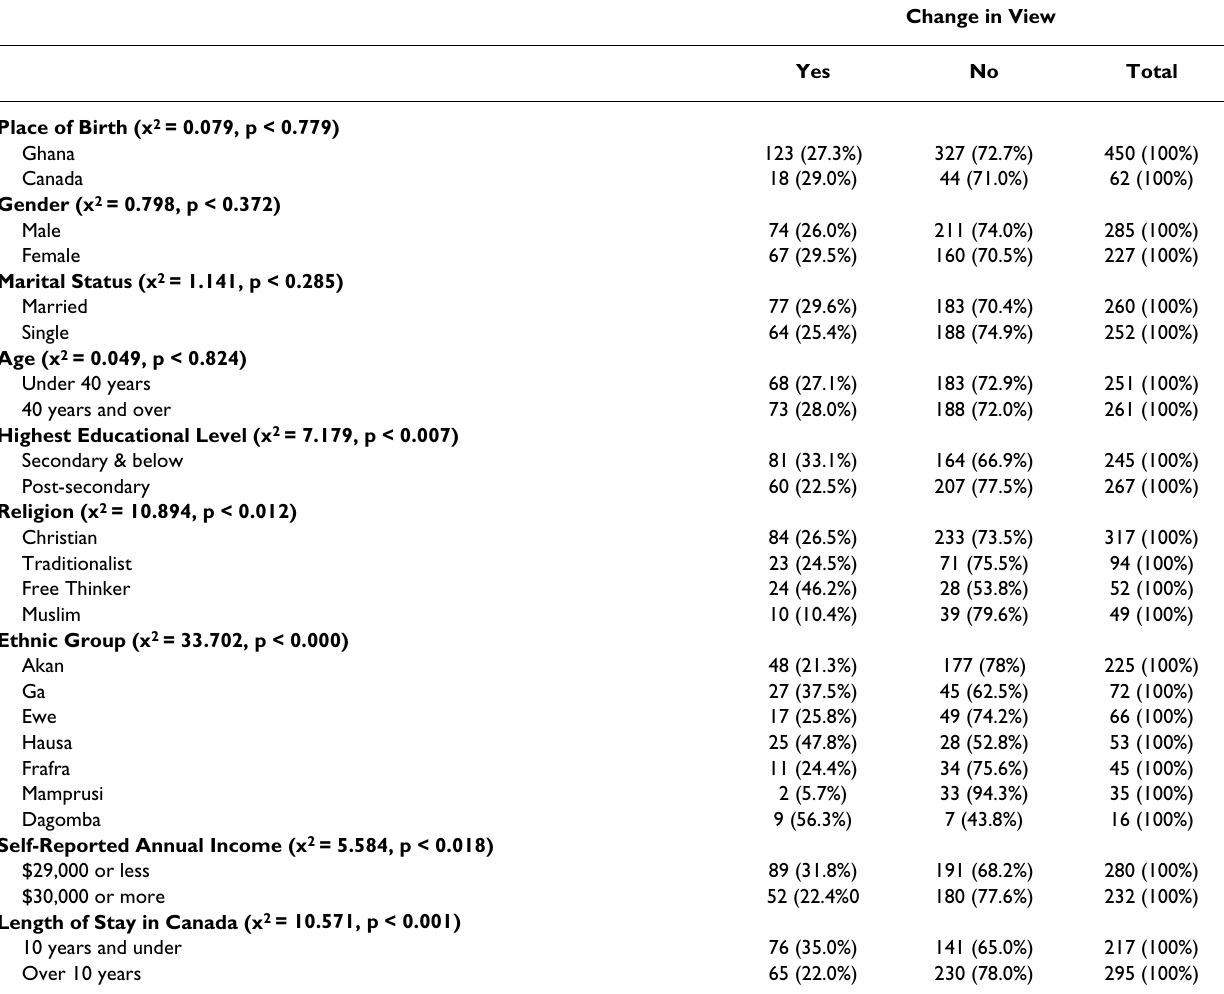
Table 2: Change In View Towards TRM (n = 512)